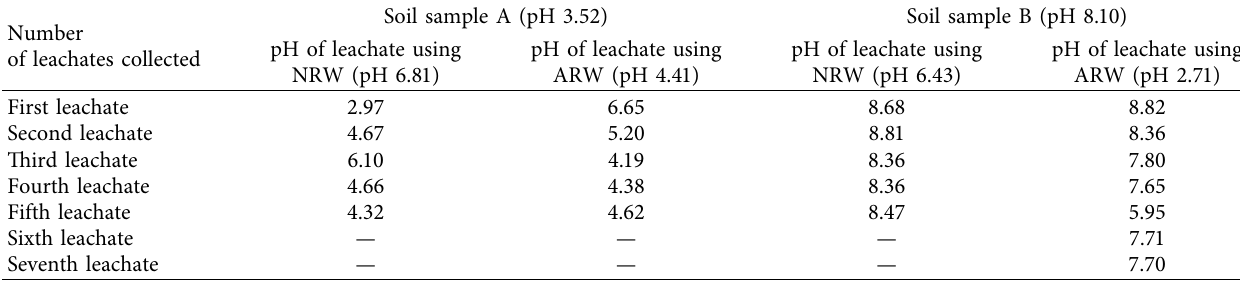
Table 1: pH values of leachate collected during the column leaching test for soils A and B.